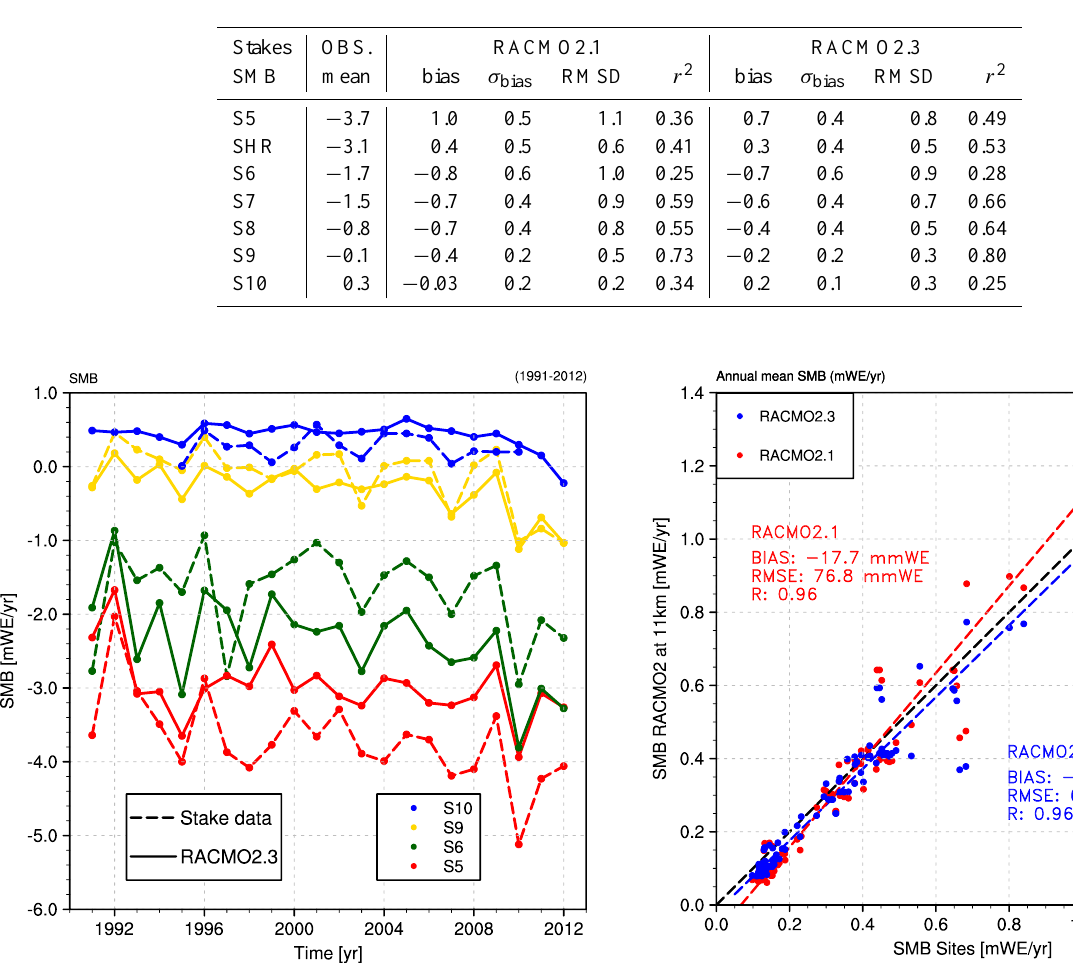
Table 4. Modelled and observed mean annual SMB (mWEyr − 1 ) and statistics of the differences at S5 (67 ◦ 06 (cid:48) N, 50 ◦ 05 (cid:48) W, 490ma.s.l), SHR (67 ◦ 06 (cid:48) N, 49 ◦ 56 (cid:48) W, 710ma.s.l), S6 (67 ◦ 05 (cid:48) N, 49 ◦ 24 (cid:48) W, 1010ma.s.l), S7 (66 ◦ 59 (cid:48) N, 49 ◦ 09 (cid:48) W, 1110ma.s.l), S8 (67 ◦ 00 (cid:48) N, 48 ◦ 53 (cid:48) W,